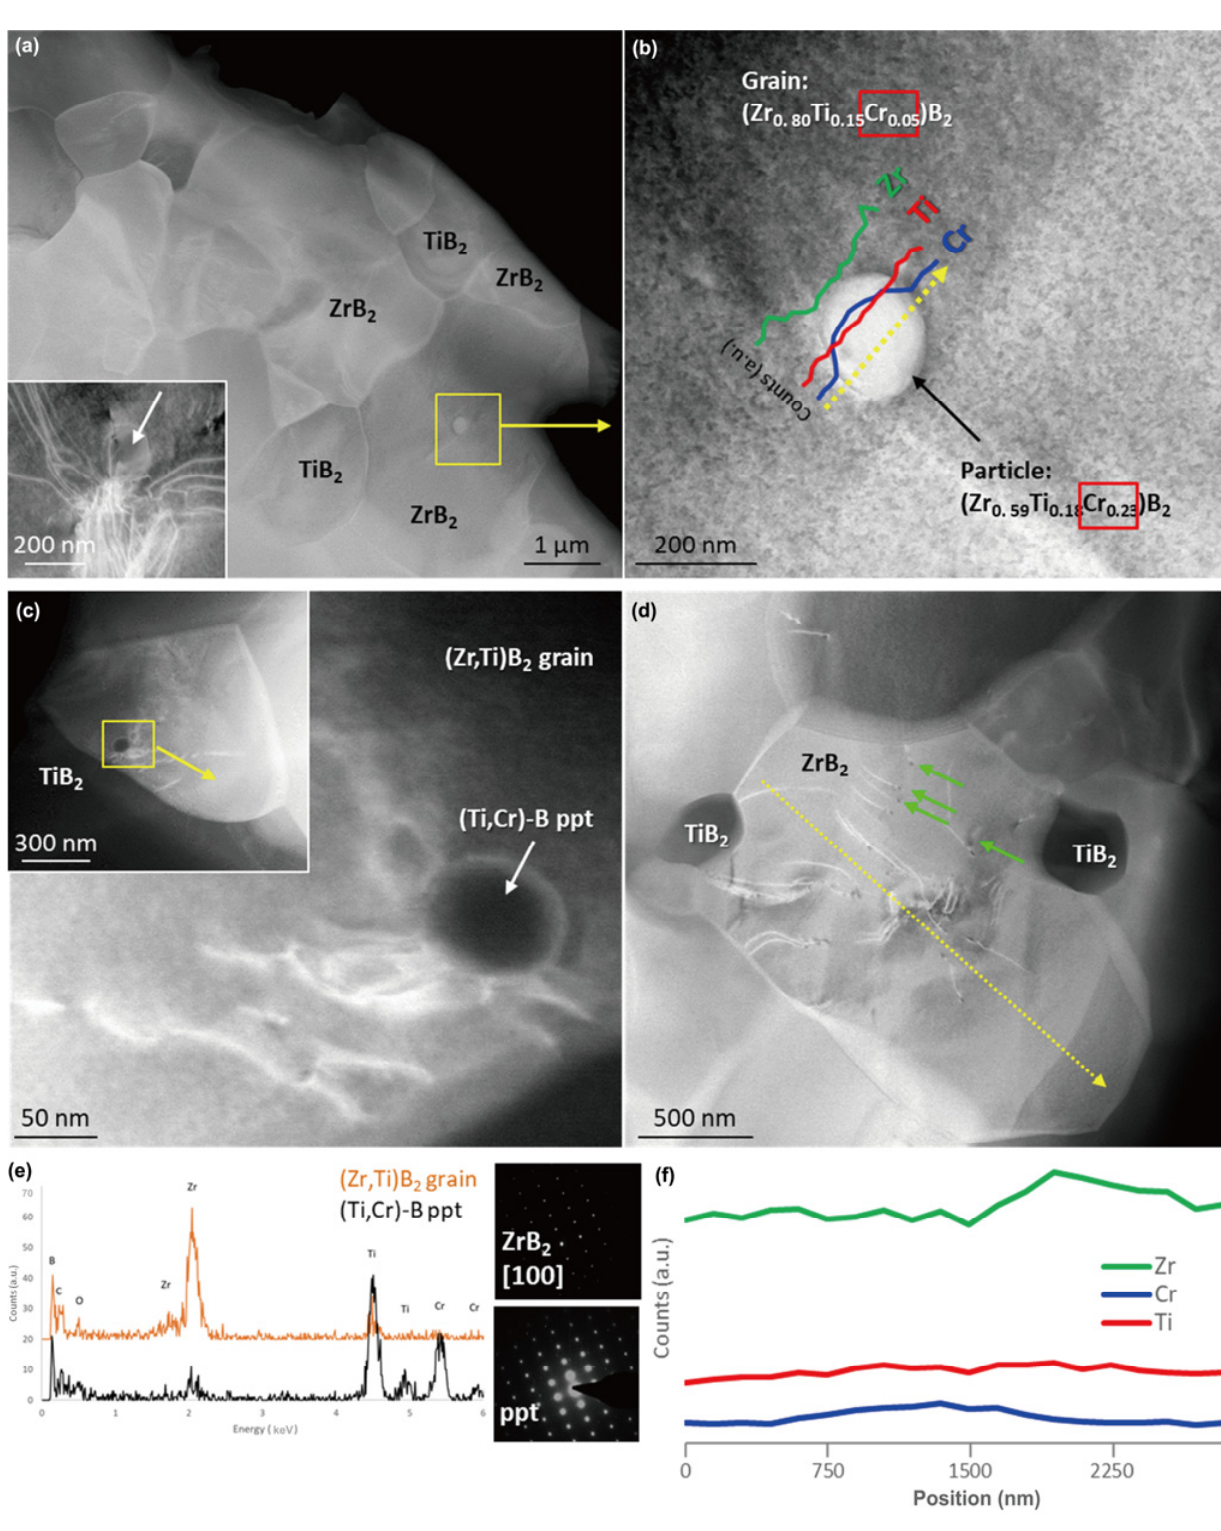
Fig. 10 TEM images of ZTC-B showing (a) an overview of ZrB 2 grains with a trapped particle with (b) corresponding linear EDS spectra overlapped, (c) another trapped inclusion at low and high magnification with (e) point EDS detecting Cr enrichment and diffraction patterns taken on ZrB 2 and the precipitate. The inset in (a) highlights the dislocation networks around the nanoparticle. (d) Overview of a ZrB 2 grain highlighting tiny dark precipitates by green arrows and (f) EDS profile scan showing no appreciable cation content variation across the whole